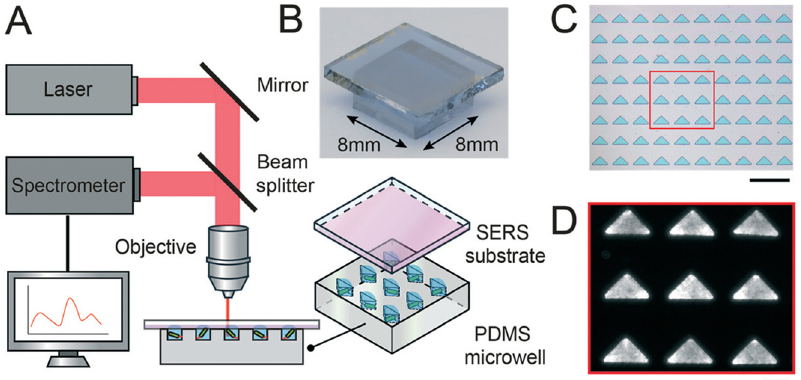
Figure 12: Zoom of surface enhanced Raman scattering (SERS) spectra of S. aureus , ATP (in red) and adenosine (in green). Reprinted with permission from Andrei et al. [67]: Springer Nature, Copyright